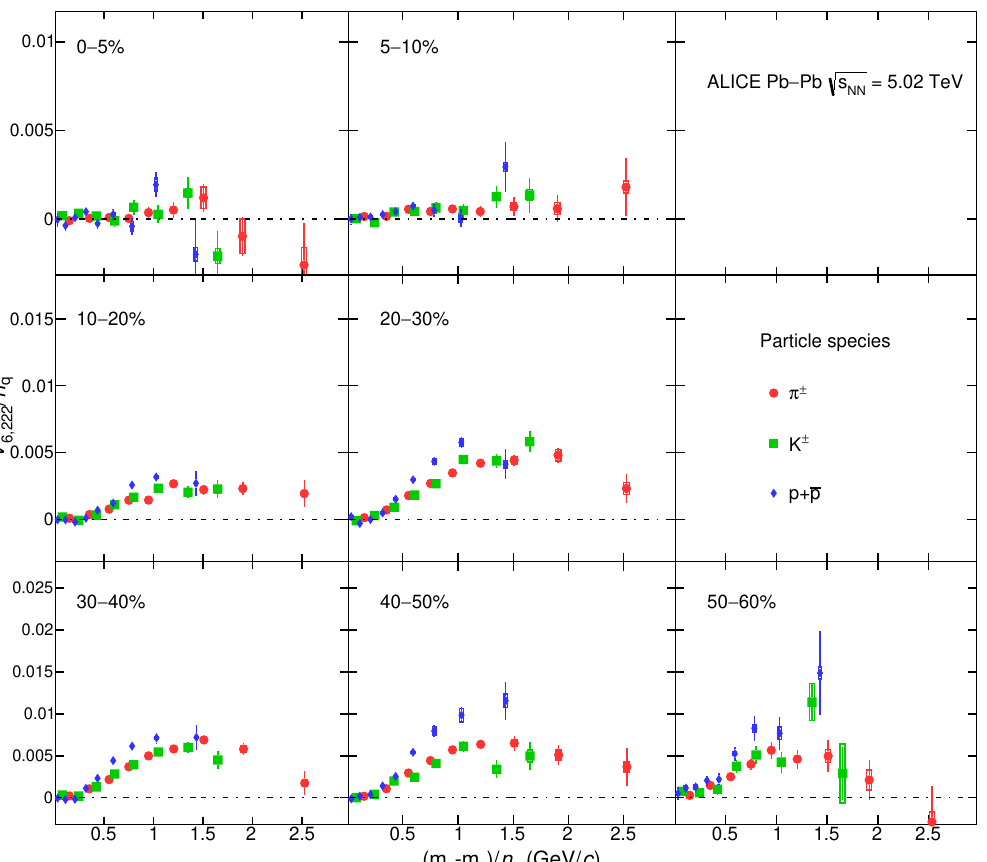
Figure 25 . The ( m T (cid:0) m 0 ) =n q -dependence of v 6 ; 222 =n q for di(cid:11)erent particle species grouped p into di(cid:11)erent centrality intervals of Pb-Pb collisions s NN = 5 : 02 TeV. Statistical and systematic uncertainties are shown as bars and boxes, respectively. It is seen that the KE T scaling holds for v 6 ; 222 at an approximate